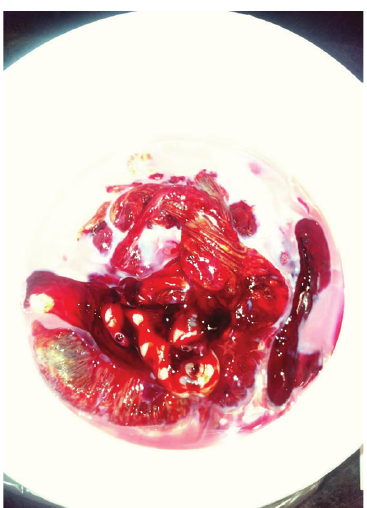
Figure 1: Placenta covered with milky fluid suggestive of severely increased serum lipid levels.